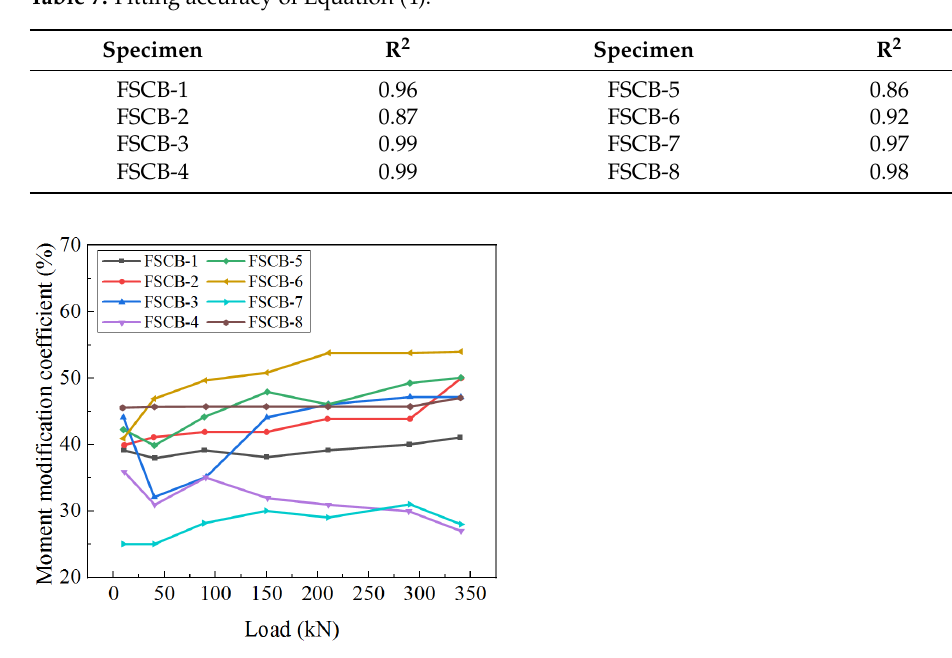
13 of 17 Figure 14. Fi tt ing curves of moment modi fi cation coe ffi cient. Table 7. Fi tt ing accuracy of Equation (4).